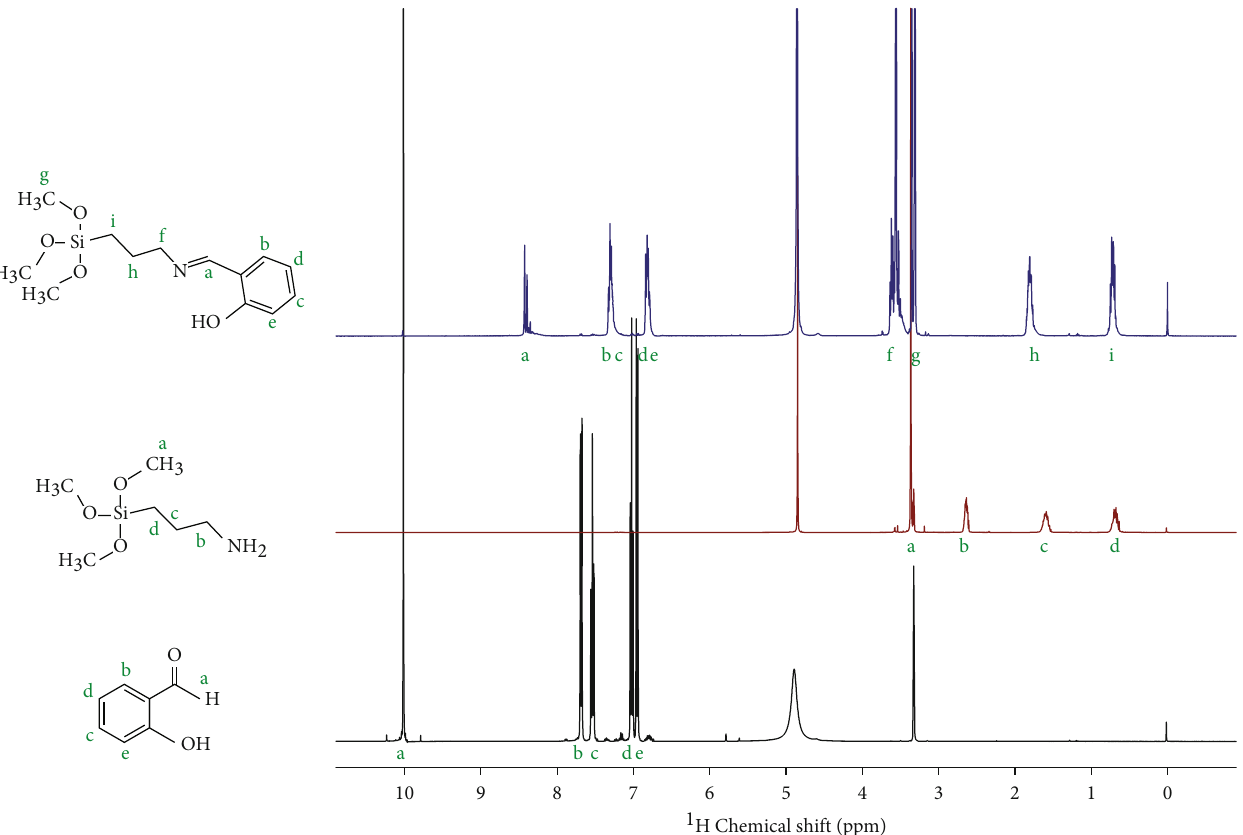
Figure 3: 1 H NMR spectra for salicylaldehyde, APTMS, and HSPTMS.